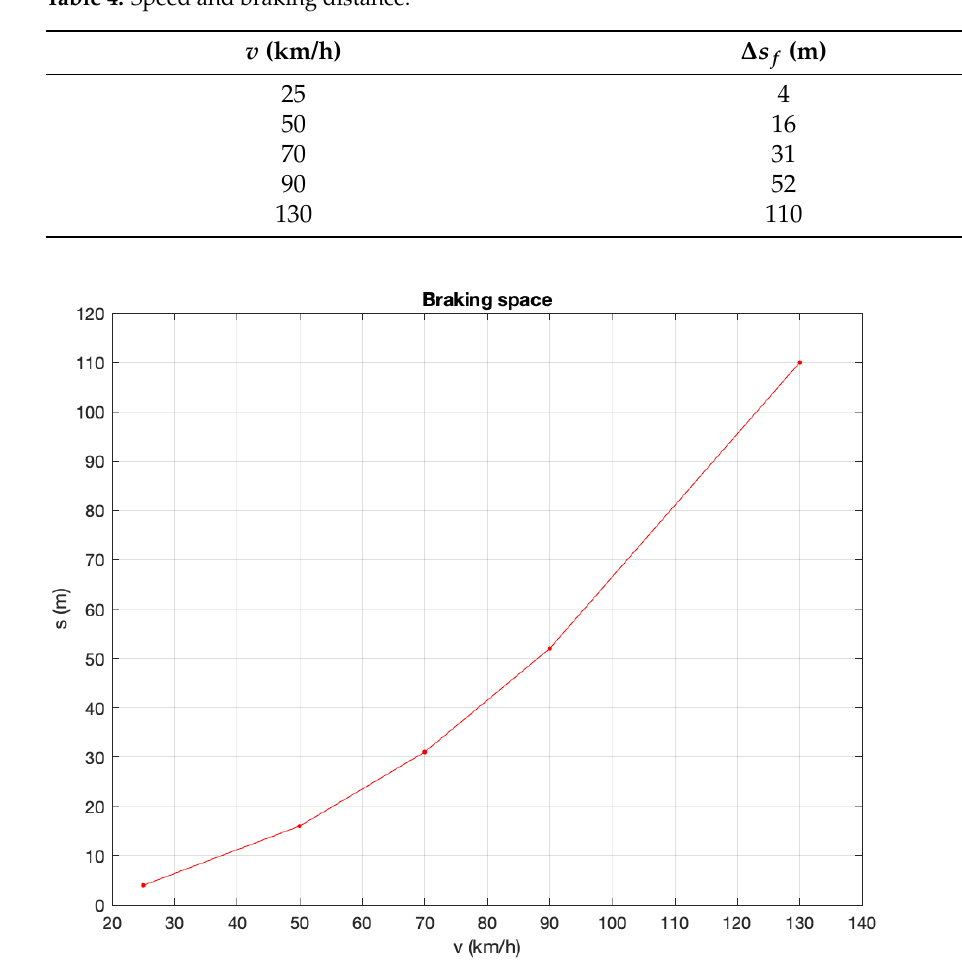
Figure 3. Braking distance